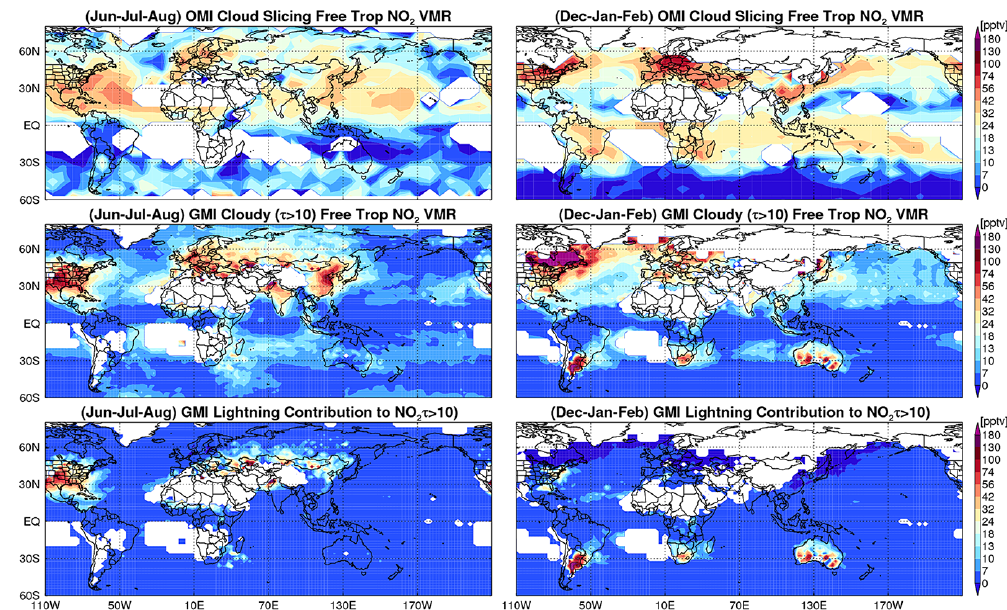
Figure 7. For June–August (left column) and December–February (right column) averages over 2005–2007; first row: climatology of free- tropospheric NO 2 VMR; second row: cloudy ( τ > 10) GMI free-tropospheric NO 2 VMR; third row: GMI lightning contribution to the free-tropospheric NO 2